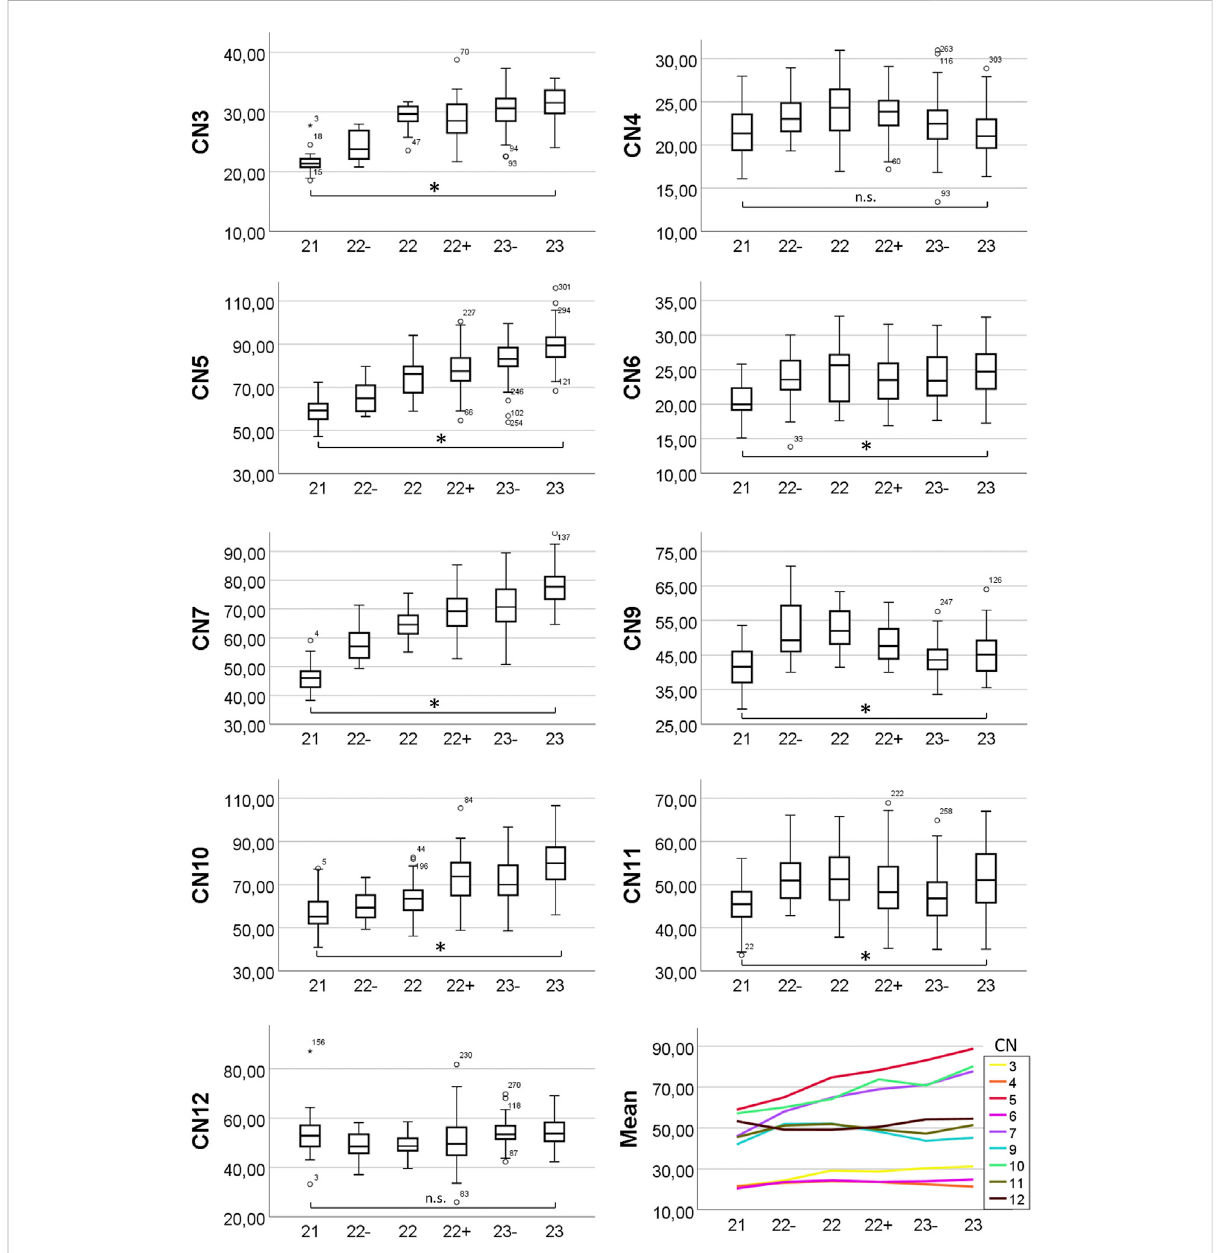
FIGURE 3 Box plots and means of measured nerve diameters. Y -axis showing diameter in micrometers, x -axis showing developmental stage. Changes in diameter were analyzed using one-way and Welch ANOVA followed by post-hoc analyses. P ≤ 0.05 was considered signi fi cant. Statistically signi fi cant diameter changes from S21 to S23 are indicated (asterisk). n. s. = not signi fi